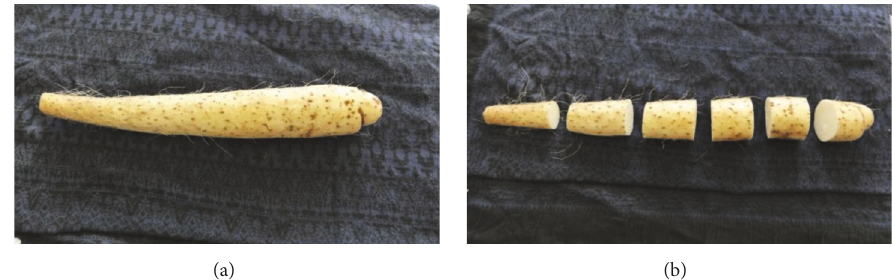
Figure 1: An example of yam (a) and seed yams (seed tubers of yam (b)).